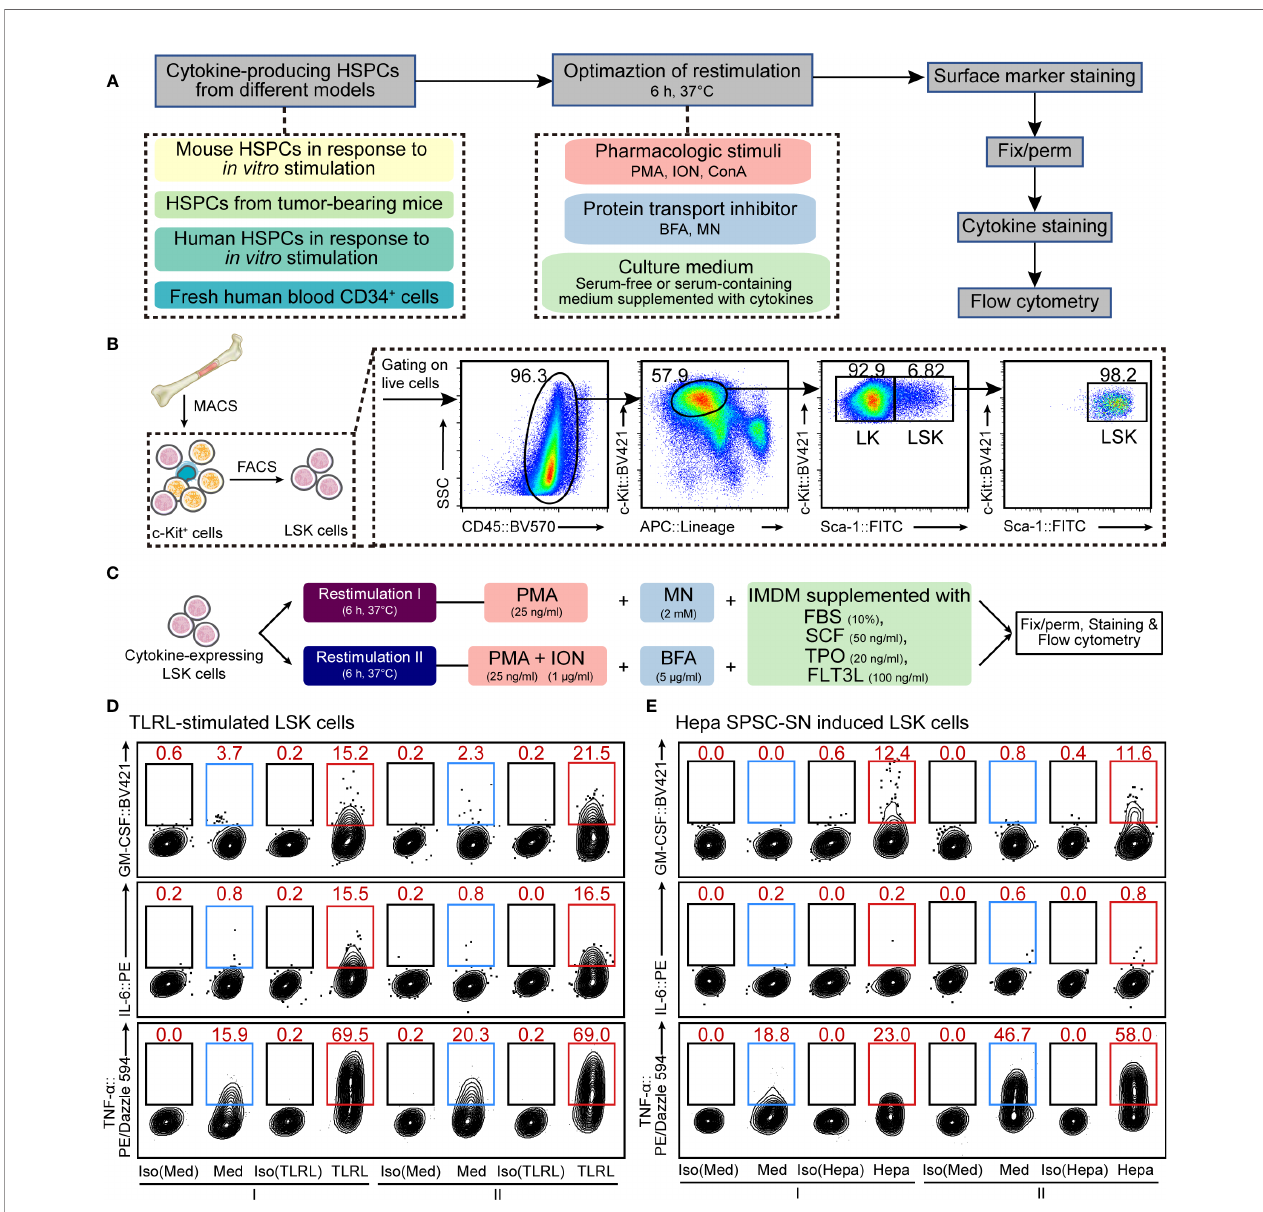
FIGURE 1 | Optimization of cellular restimulation strategy. (A) Schematic representation of the experimental approach. (B) Schematic representation of HSPC isolation and the fl ow cytometry sorting strategy. (C) Two restimulation strategies, combining pharmacologic stimuli, protein transport inhibitor and culture system, were selected based on the results shown in Supplemental Figures 2 – 5 . (D, E) Representative fl ow cytometric analysis of cultured LSK cells exposed to LPS and Pam3CSK4 (D) or Hepa SPSC-SN (E) . The intracellular GM-CSF, IL-6 and TNF- a levels were examined. The data refer to a typical experiment out of three that generated similar results. The numbers in the fl ow cytometry plots indicate the proportions of gated cells. Naïve LSK cells were cultured in the indicated medium for 12 h (D) or 4 days (E) before restimulation. After that, cells were washed and cultured in the restimulation conditions as indicated for an additional 6 h before staining. I, restimulation I; II, restimulation II; Med, control medium (SFEM + SCF); TLRL, control medium supplemented with 100 ng/ml LPS and 1 m g/ml Pam3CSK4; Hepa, control medium supplemented with 5% (v/v) Hepa mice-derived SPSC-SN; BV421, Brilliant Violet 421; PE,